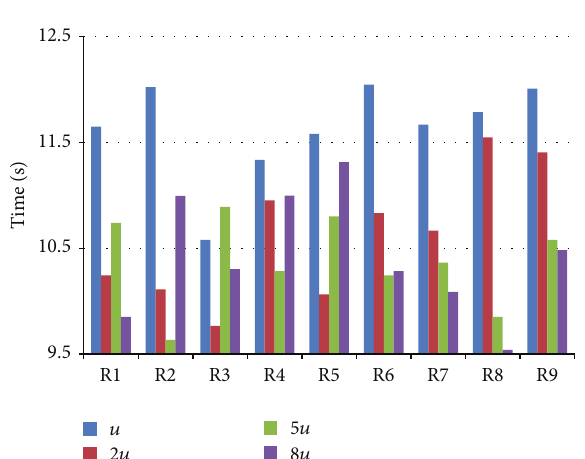
Figure 10: Ten runs of old GA algorithm with 𝑢,2𝑢, 5𝑢 , and 8𝑢 generations.